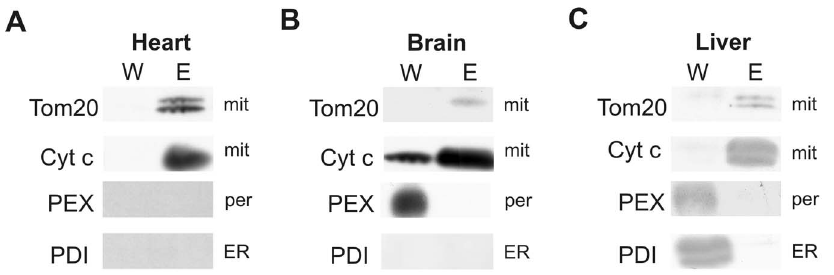
Figure 1. Efficient mitochondrial isolation from mouse tissues using the anti-TOM22 magnetic beads method. Proteins of wash (W) and elution (E) fractions were compared by Western blot analysis from A heart, B brain and C liver tissues. Anti-TOM20 and anti-cytochrome c antibodies were used to detect mitochondrial marker proteins (mit). Anti-PEX1 and PDI antibodies were used to detect peroxisomal (per) or endoplasmic reticulum (ER) marker proteins, respectively.